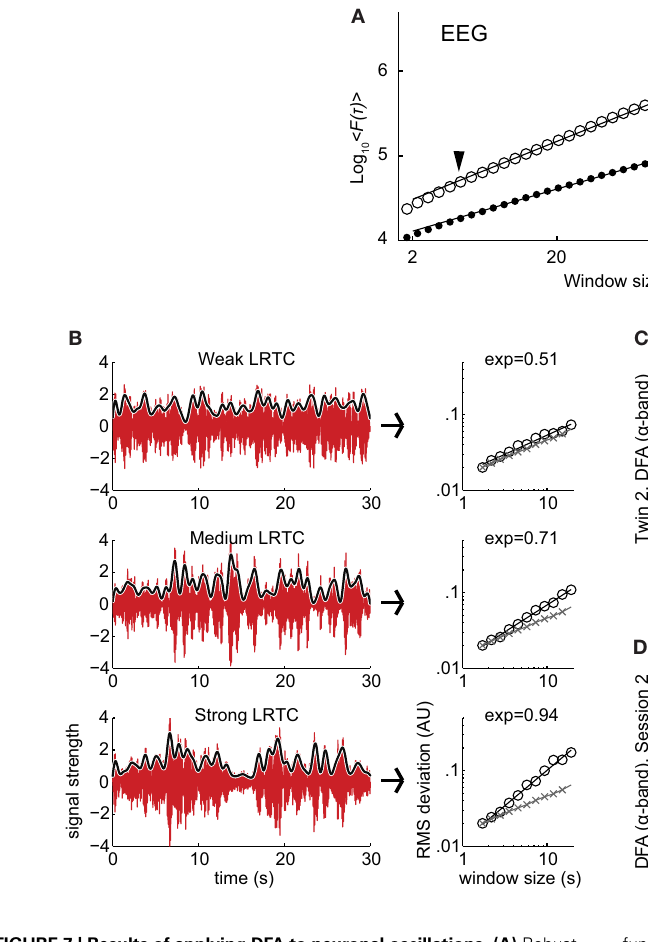
FIGURE 7 | Results of applying DFA to neuronal oscillations. (A) Robust long-range temporal correlations are observed in the amplitude envelope of human EEG alpha oscillations using the DFA. Circles , eyes-closed rest condition; Dots , surrogate data (Figure modified from Linkenkaer-Hansen et al., 2001). (B) Differences in the scale-free modulation of the amplitude envelope of neuronal oscillations are prominent among individuals and can be quantified using DFA. Here shown for three filtered EEG signals (6–13Hz) with weak ( top ), medium ( middle ), and strong ( bottom) LRTC (from channel O2).The gray lines represent the amplitude envelope (low-pass filtered, 1Hz). DFA fluctuation functions are shown to the right, with signal ( circles) , and white-noise ( crosses ).The DFA exponent is the slope of the fluctuation